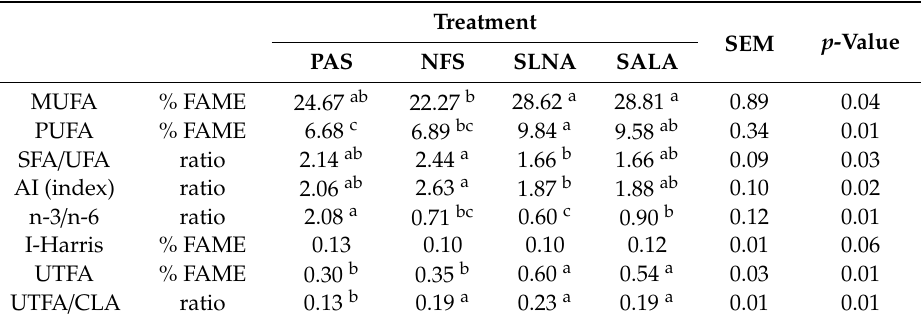
Table 1. Fatty acid classes and indices of milk from sheep grazing only fresh herbage compared to di ff erent levels of oilseed supplementation [44].